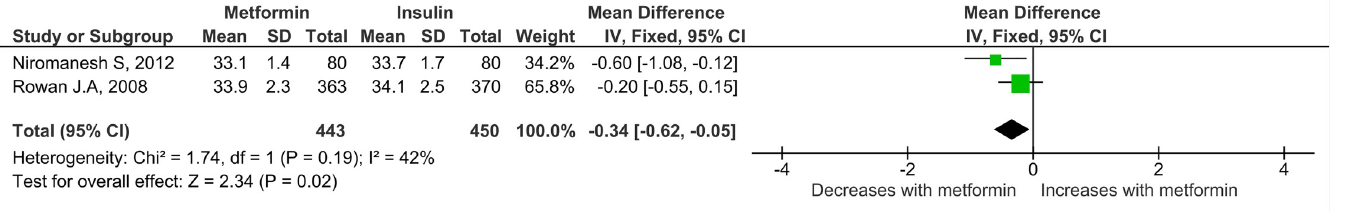
Fig 10. Neonatal chest circumference. Expressed as mean difference (fixed effects model) and 95% CI. IV, mean difference.